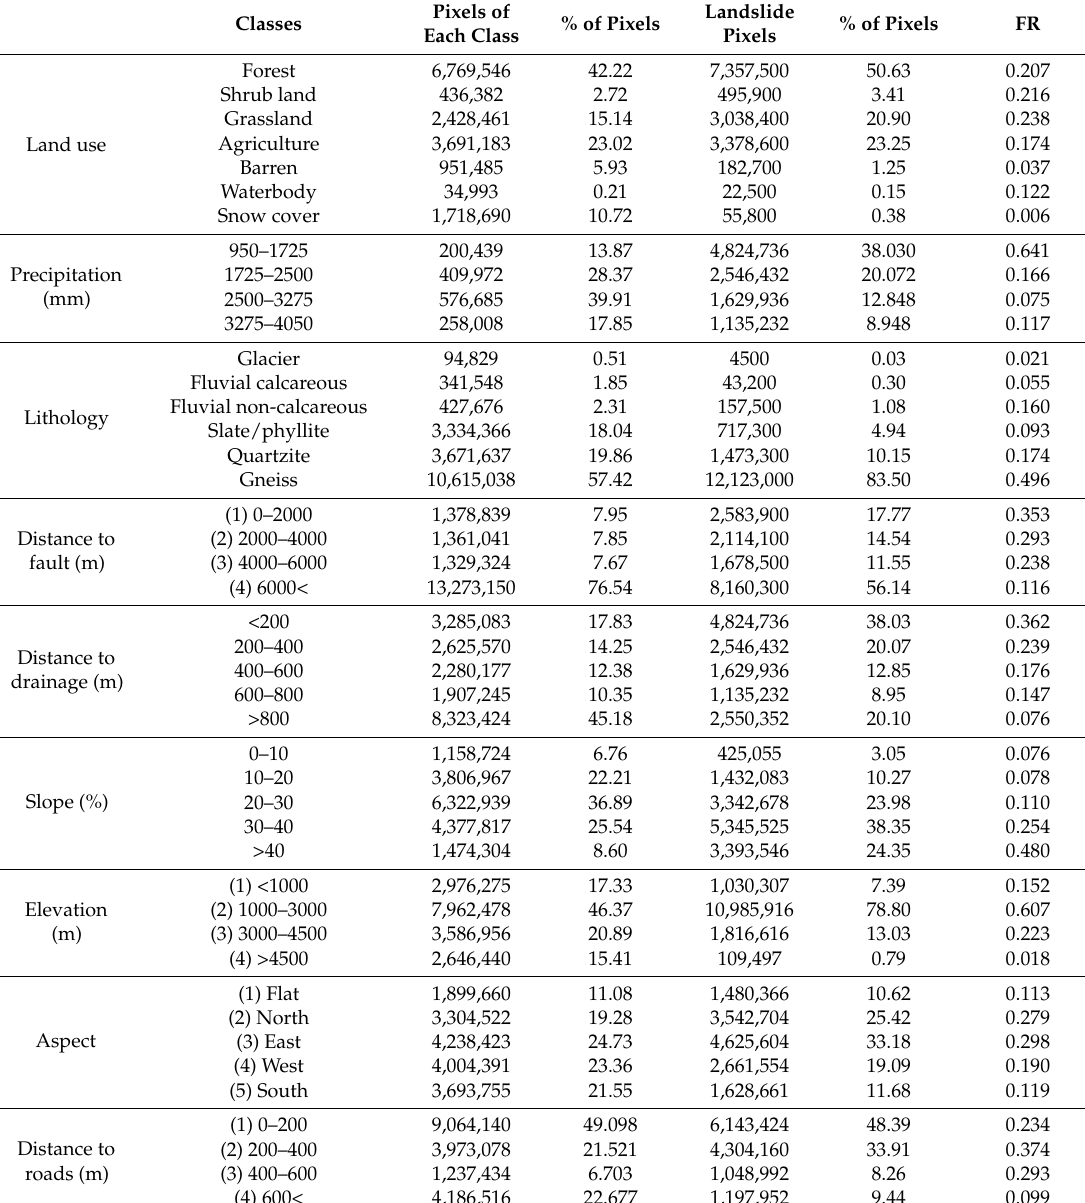
Table 5. The normalized weights for the classes of the factors based on the frequency ratio (FR) model. Pixels of Landslide % of Pixels % of Pixels Classes Each Class Pixels